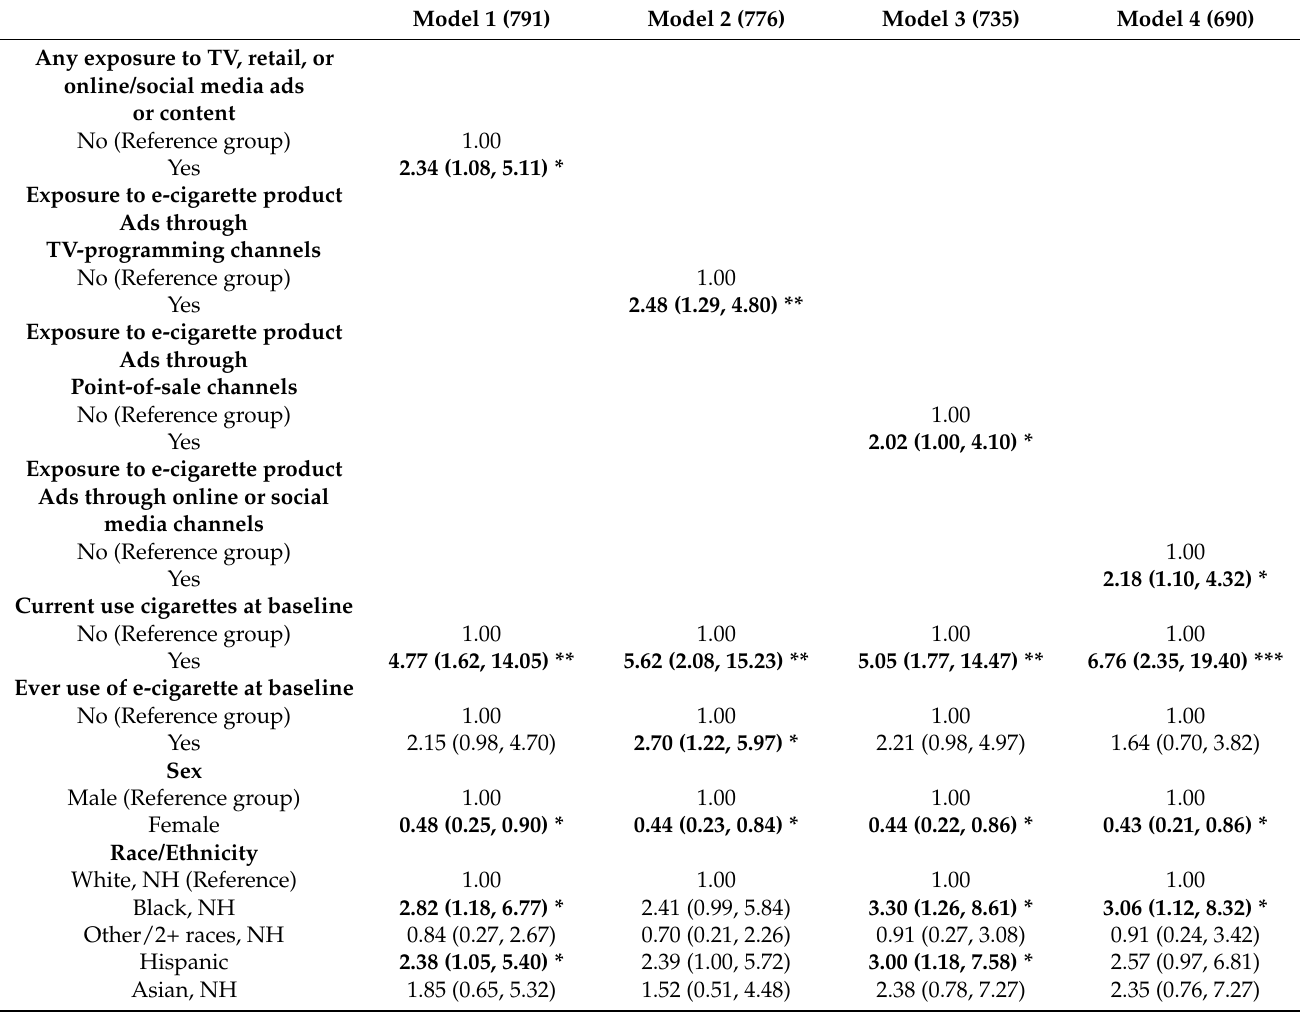
Table 4. Effect of e-cigarette advertising exposure on past 30-day e-cigarette use among young